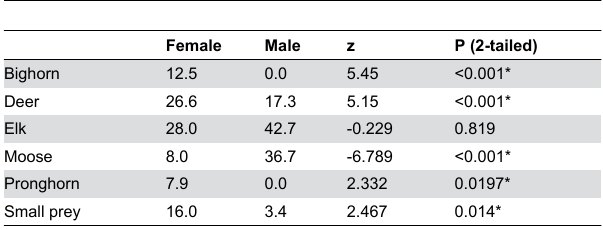
Table 2. A comparison of proportions (%) of different prey killed by male and female cougars, and the results of the two-proportions z-test.